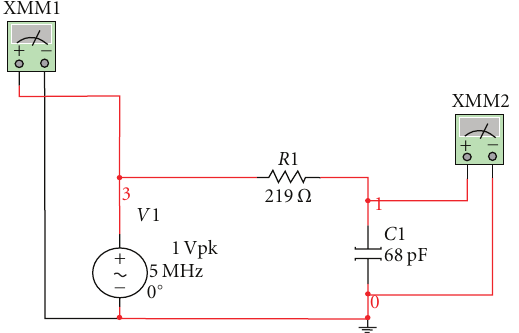
Figure 4: MULTISIM model of sensor having resistance 219 Ω